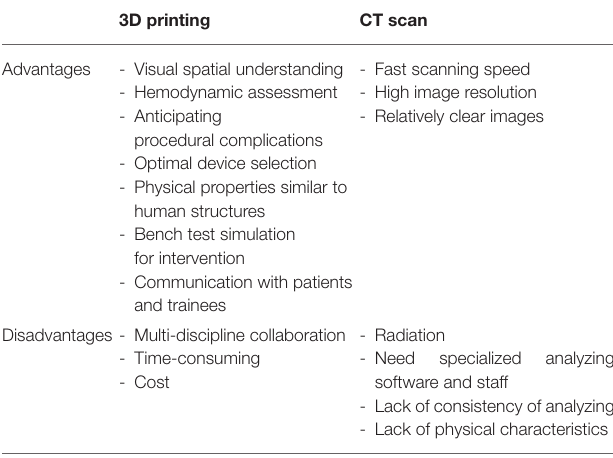
TABLE 1 | The advantages and disadvantages between 3D printing and CT